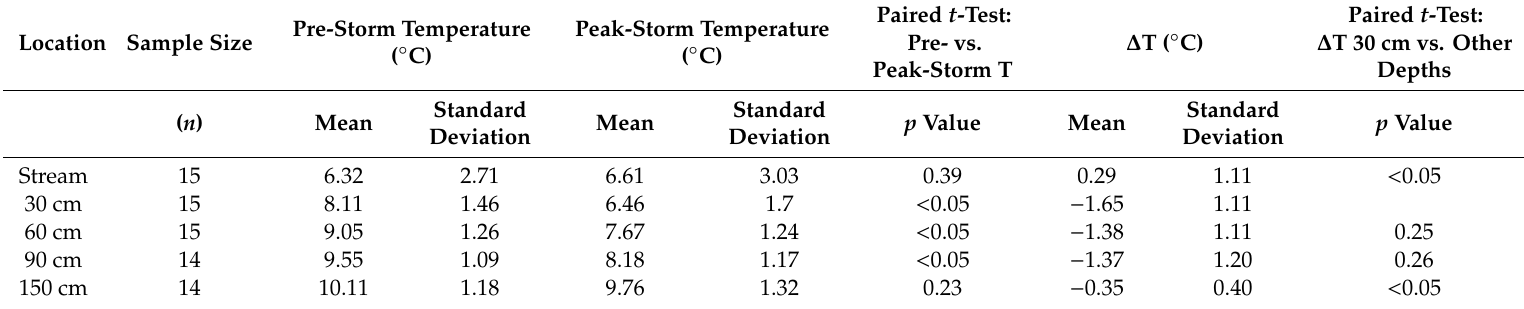
Table 1. Summary statistics of cold pre- and peak-storm temperatures and after-storm thermal amplitude change ( ∆ T).